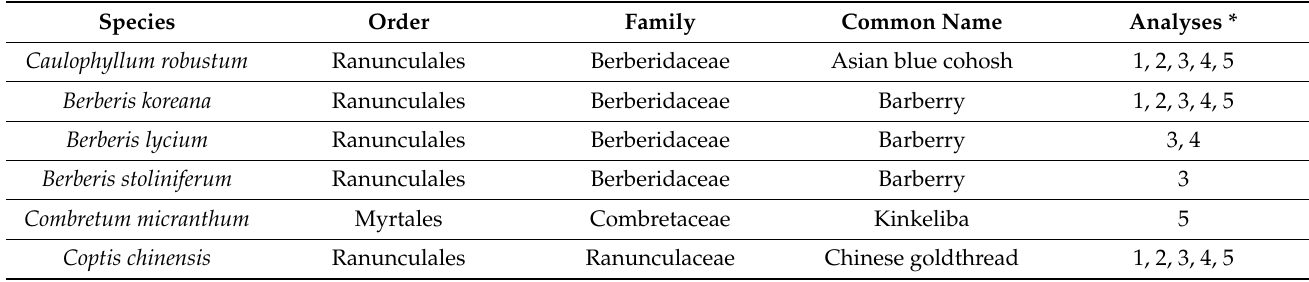
Table 1. Plant species used for mining BIAs biosynthetic